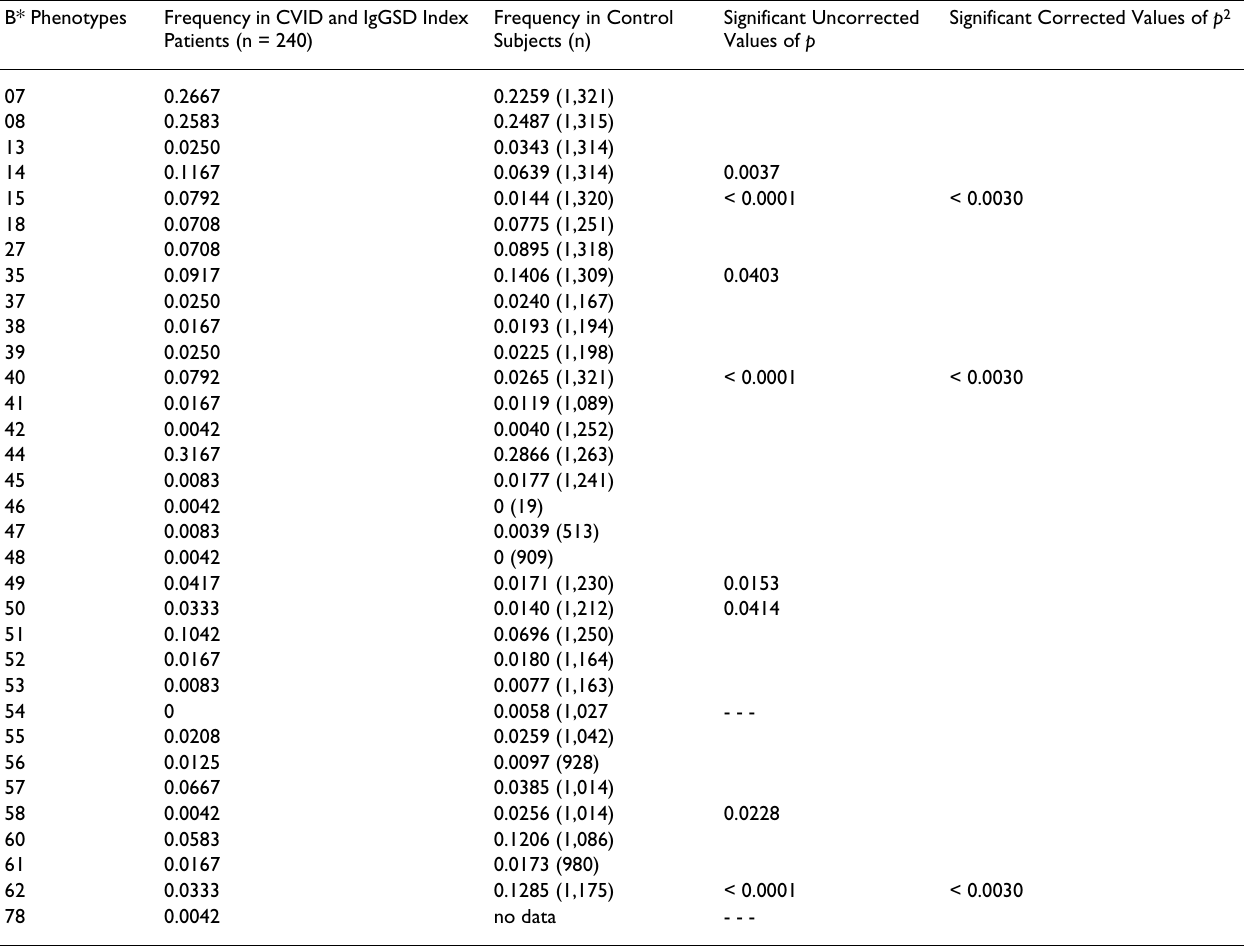
Table 3: Phenotype Frequencies of HLA-B Alleles in Alabama Subjects. 1 B*